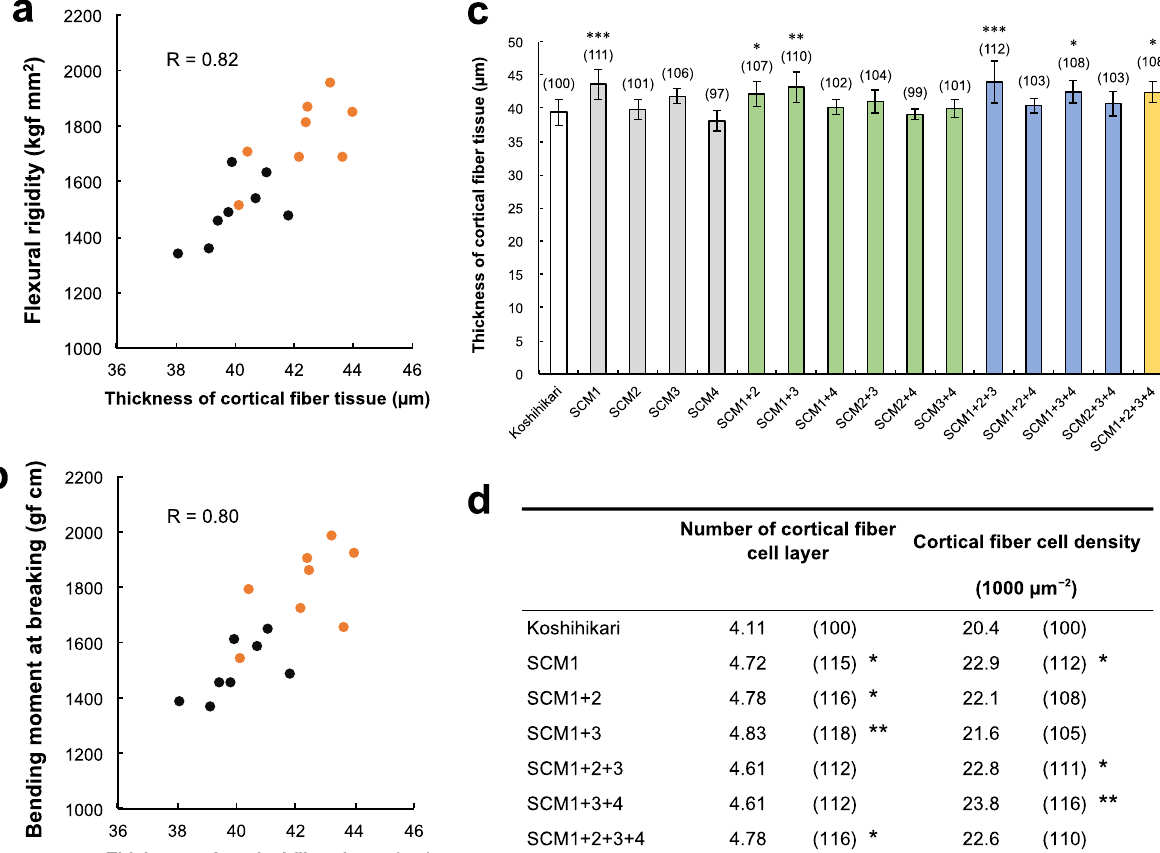
Habataki genome segment has thick culms compared with Koshihikari. It has been reported that the null gn1a improved lodging resistance through increasing the culm diameter 13 . isolated as an effective QTL, and the causal gene is identical to FC1 in rice 14 . This gene has been reported to number. Substitution lines also have a positive role in enhancing culm diameter and spikelet number per panicle. The effects of SCM genes on morphological traits related to tillering, such as culm length and panicle length,